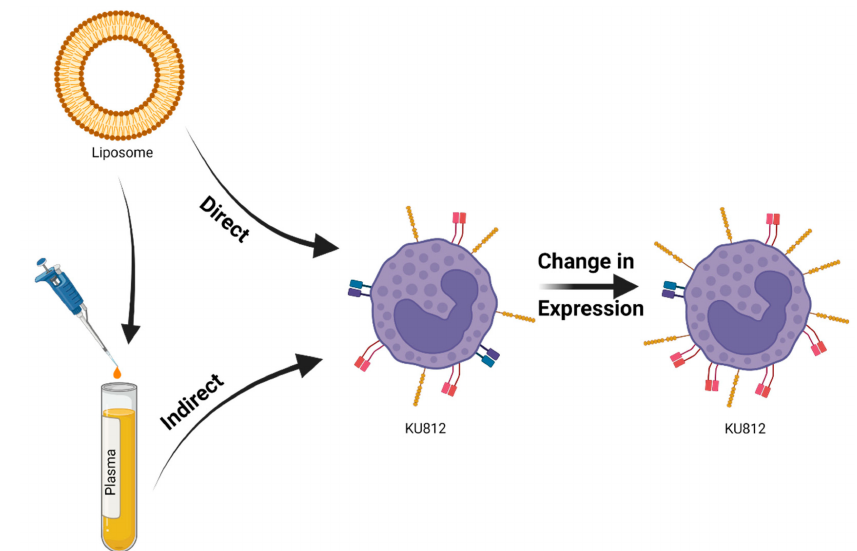
Figure 2. Visualisation of the routes used to expose KU812 cells within the enclosed work, through “direct” spiking of the materials onto the populations, or “indirect” treatment of an intermediate (plasma) which was then used to resuspend the